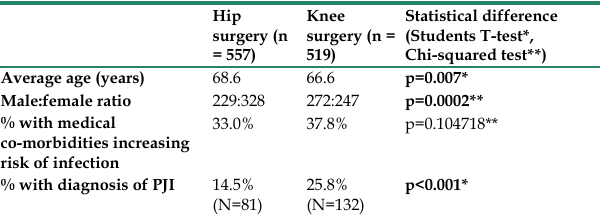
Table 3: Number of intra-operative samples taken from the study cohort Mean number of samples (range)